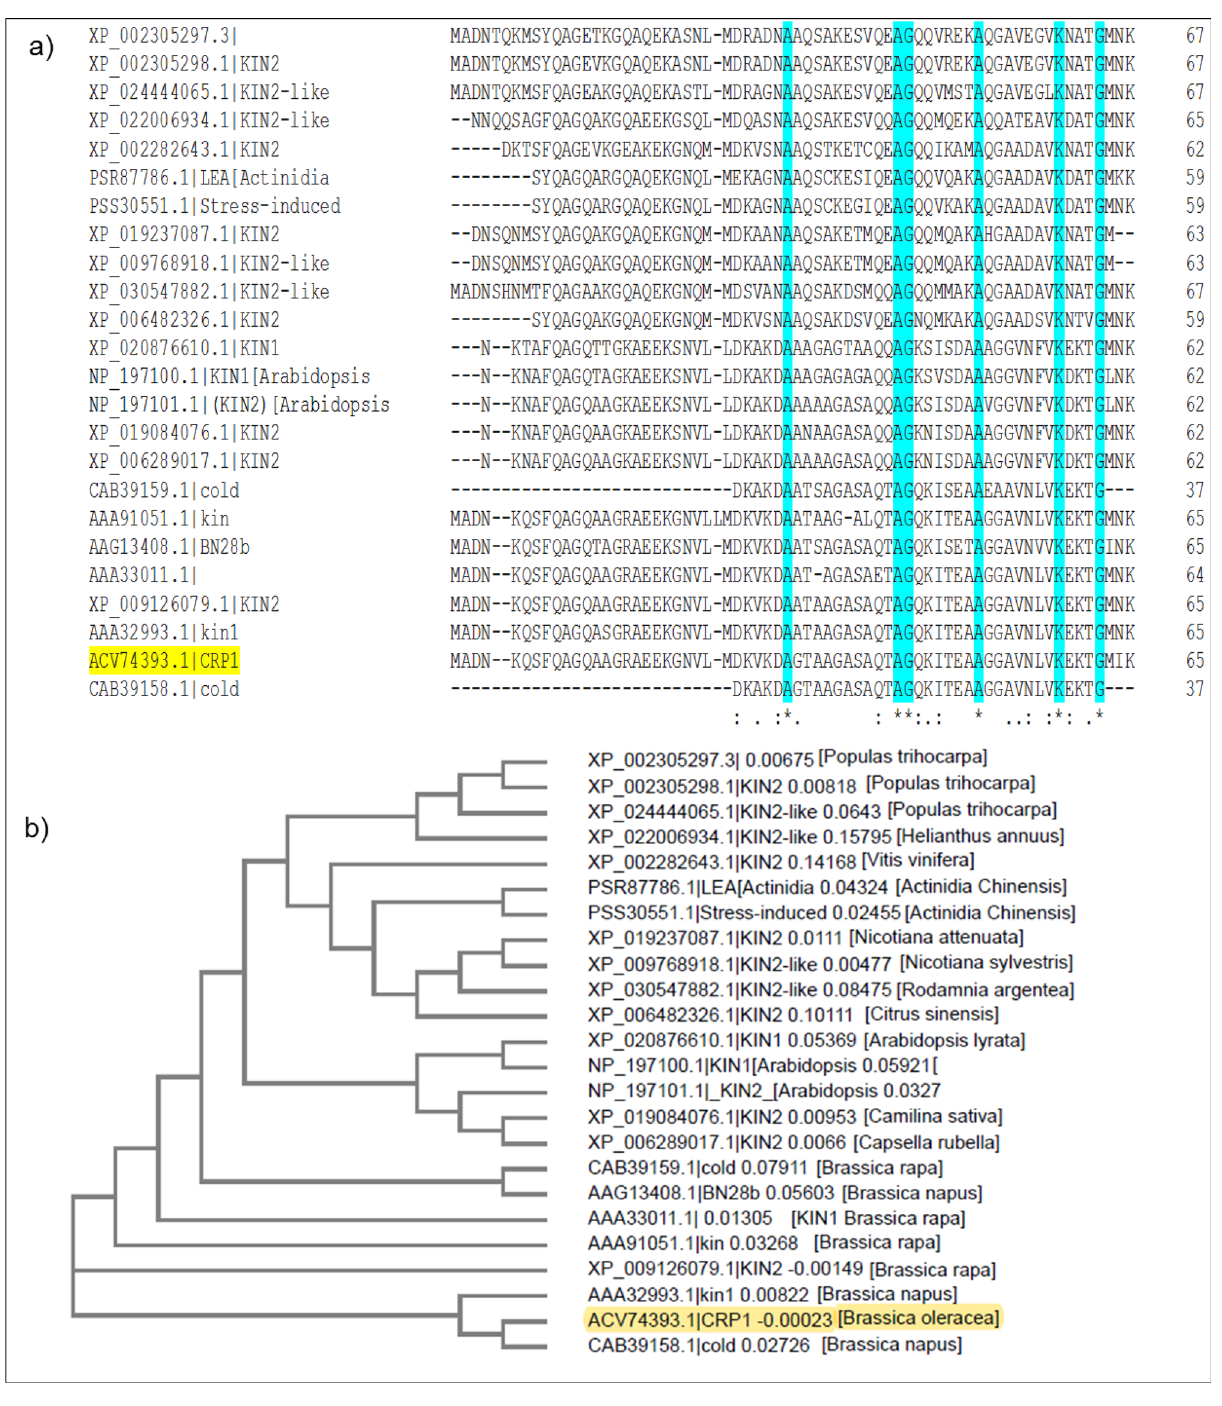
Figure 1. Sequence alignment and phylogeny of BoCRP1 homologues. ( a ) Multiple sequence alignment of amino acid homologues. Identical conserved consensus amino acids are indicated by asterisks, whereas conserved substitutions are indicated by colons and periods. ( b ) A phylogenetic tree was constructed using ClustalW2 program by neighbor-joining